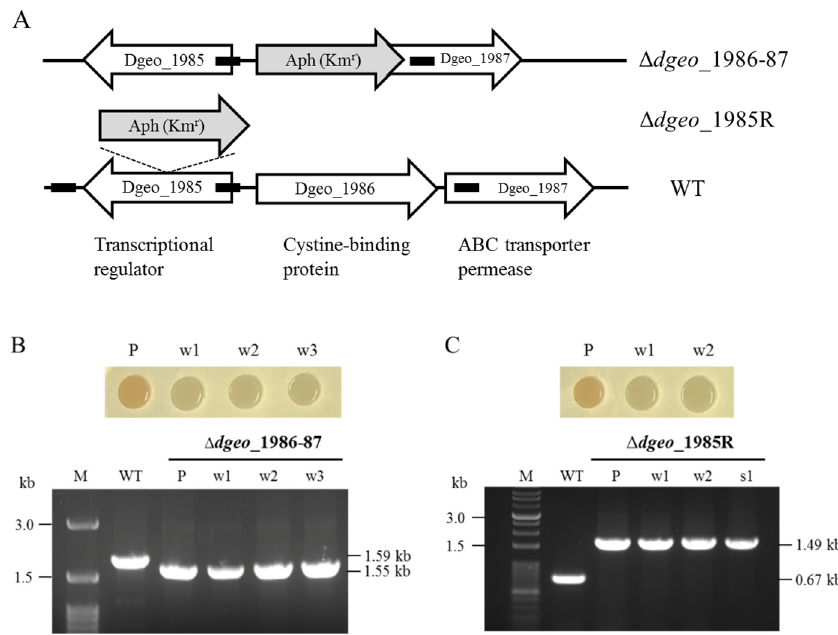
Figure 1. PCR confirmed both parent strains ∆ dgeo _1986-87 and ∆ dgeo _1985R, and their non-pigmented colonies induced by hydrogen peroxide, as well as the wild-type strain. Schematic illustration of mutant construction ( A ). Phenotypic difference between parent (p) and non-pigment strains (w) and PCR confirmation with primer set encompassing target genes for dgeo _1986-87 ( B ) and dgeo _1985R ( C ). Lanes: M, size marker; WT, wild-type; P, parent strain; w, non-pigment strains; s, streptomycin-resistant strain.